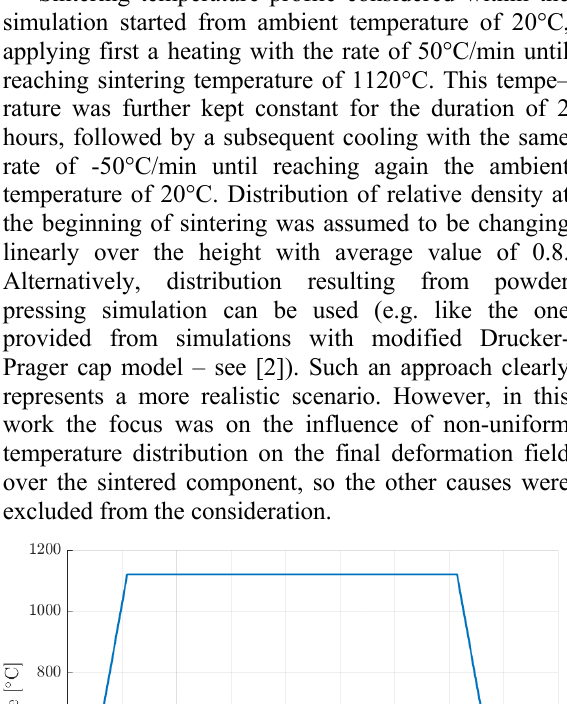
rature was further kept constant for the duration of 2 rate of -50°C/min until reaching again the ambient